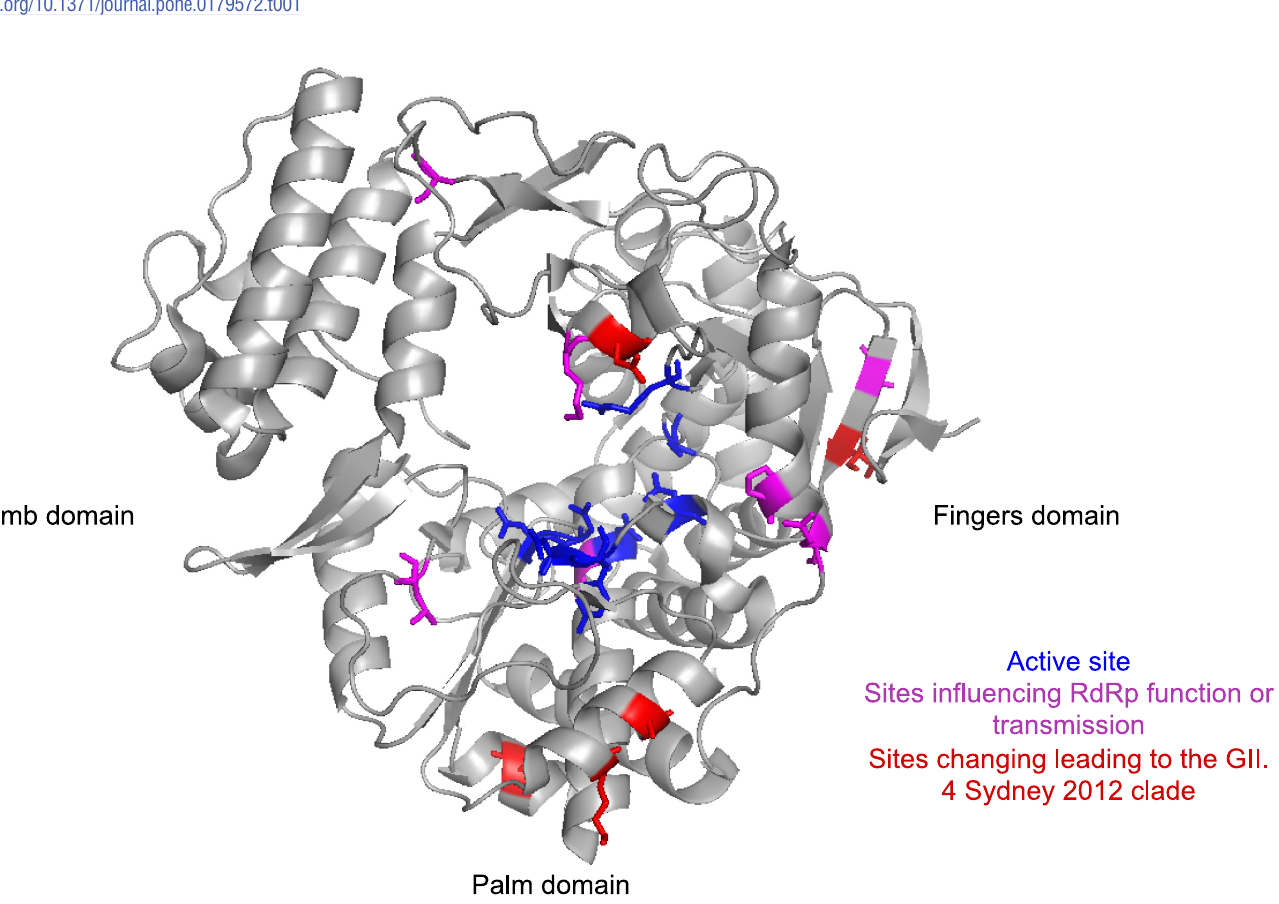
Each nonsynonymous change that occurred along the branch in the ORF1 and RdRp phylogenetic trees leading to the GII.P16-GII.4 Sydney 2012/GII.3/ GII.2 clade is shown. N/A—not applicable.